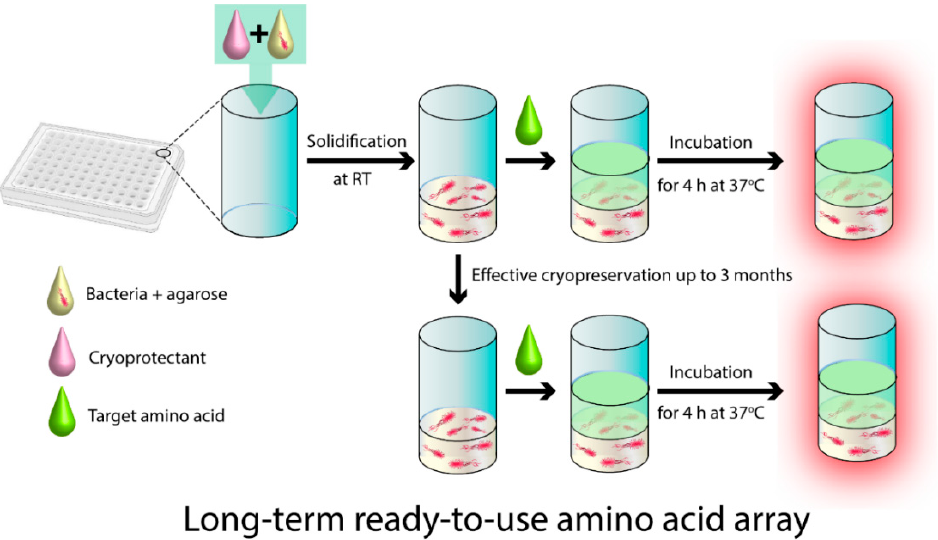
Figure 1. Schematic illustration of the ready-to-use amino acid array comprising amino acid auxotrophic bioluminescent Escherichia coli immobilized within the agarose gel and supplemented with an optimal cryoprotectant in individual wells of a 96-well plate. The amino acid array can be defrosted at any time during the cryopreservation period and used for the analysis of amino acids.